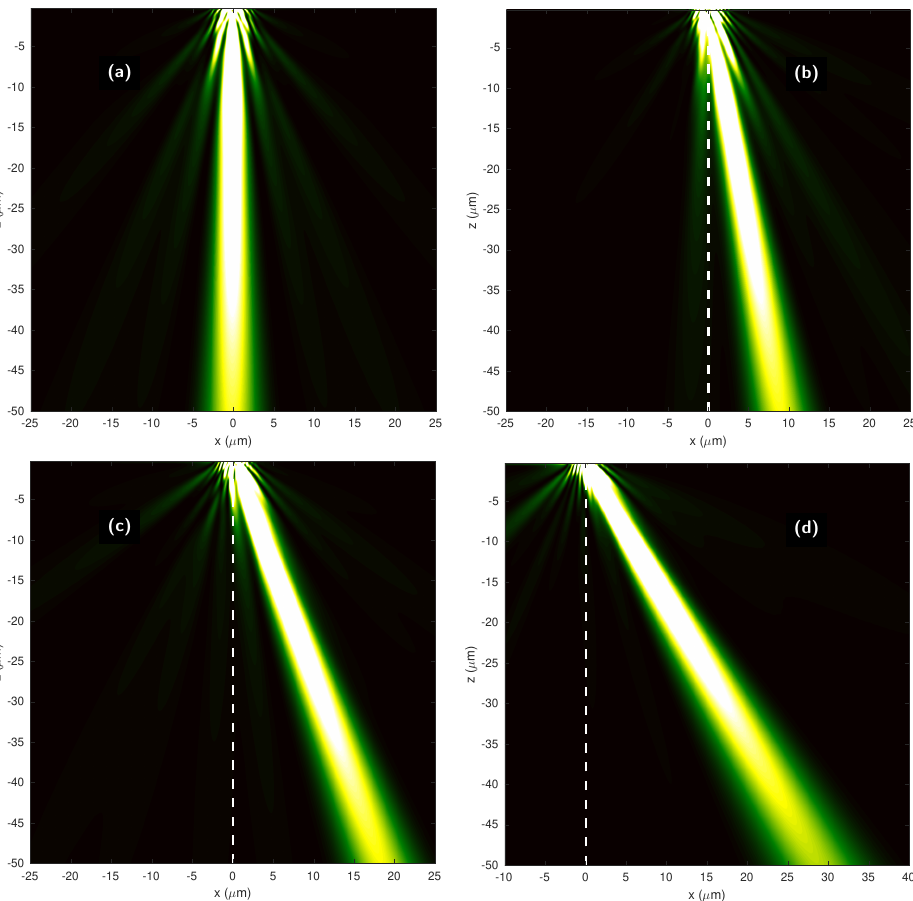
2 distributions for optimum single-beaming cases. The H y | |